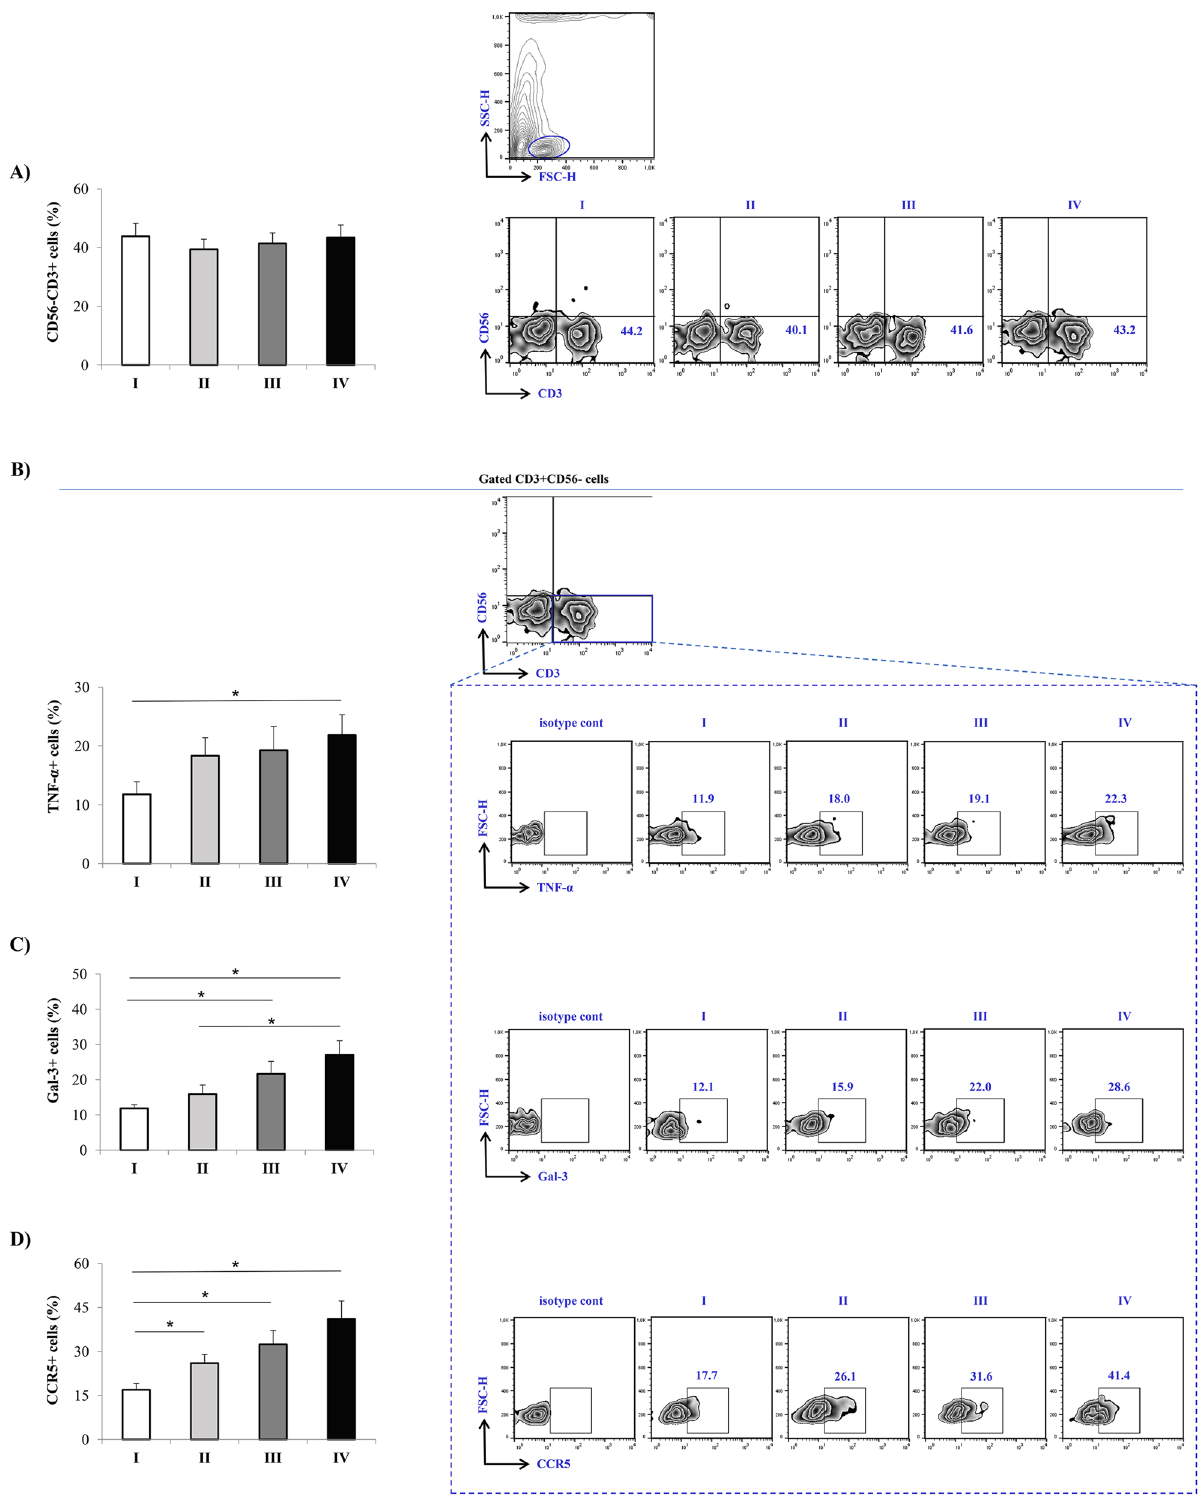
Figure 2. Increment in percentage of TNF-α + , Gal-3 + , and CCR5 + T cells in stage IV patients with COVID- 19. The graph and representative FACS plots displaying the percentage of CD56 - CD3 + , CD56 − CD3 + TNF-α + cells, CD56 − CD3 + Gal-3 + cells, CD56 − CD3 + CCR5 + cells, among PBMCs of patients in all progressive stages of COVID-19 (stage I (n = 19), II (n = 21), III (n = 22), IV (n = 24). Isotype control for each measured marker is also displayed. The Kruskal–Walli’s test (with post-hoc Mann–Whitney U -test) was applied to evaluate statistically significant differences. *p <